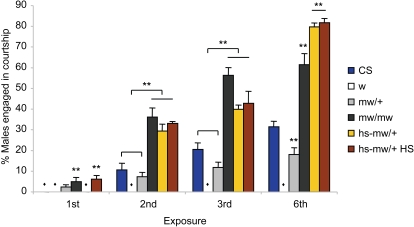
Ethanol-induced courtship and sedation of w and transgenic w males.
w1118 males did not display any discernible ethanol-induced intermale courtship upon recurring ethanol treatment, which was reversed by transgenic w expression in mw+/+, mw+/mw+, and hs-mw+/+ without (hs-mw+/+) and with heat shock (hs-mw+/+ Hs). Diamonds denote no courtship observed. General linear model revealed the significant effects of exposure, genotype, and interaction (exposure effect, F3,167 = 266.85, p<0.0001; genotype effect, F5,167 = 181.04, p<0.0001; double asterisks, significant difference by Tukey-Kramer tests in each exposure; interaction, F15,167 = 28.23, p<0.0001; n = 3–11).